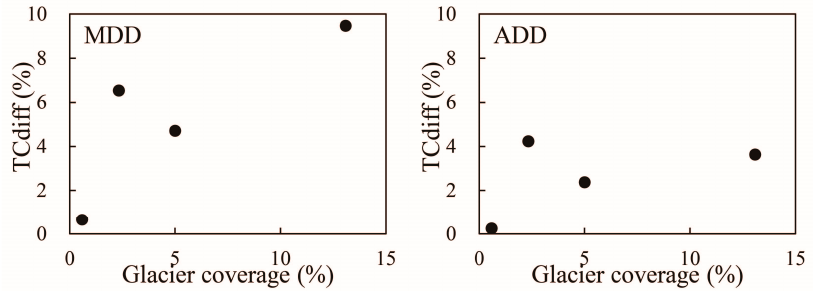
Figure 4. Differences of contributions of the temperature indices to the runoff indices between dry and wet summers (TCdiff) against the glacier coverage. wet summers (TCdiff) against the glacier